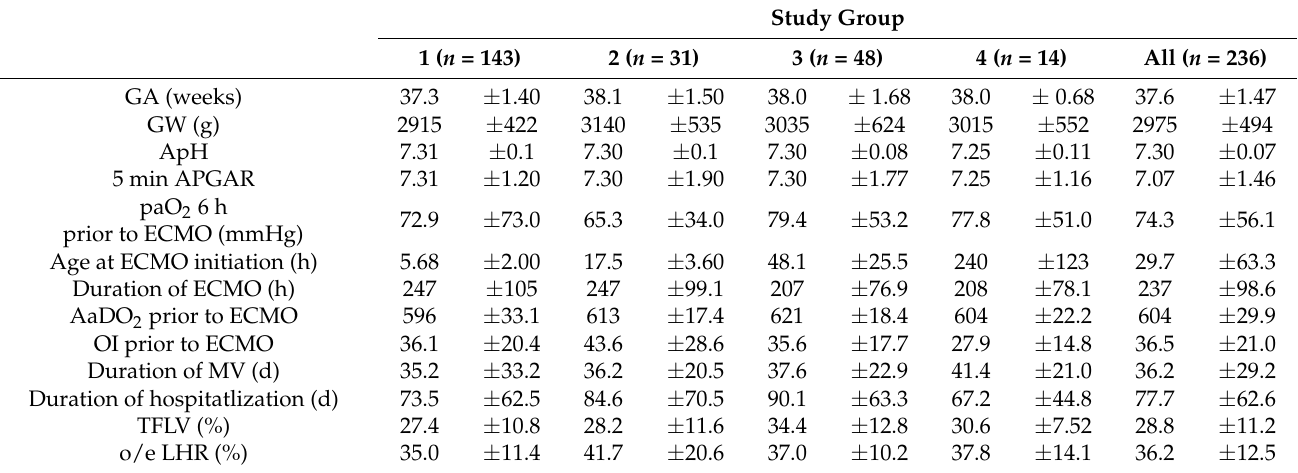
Table 1. Clinical data for each study group.